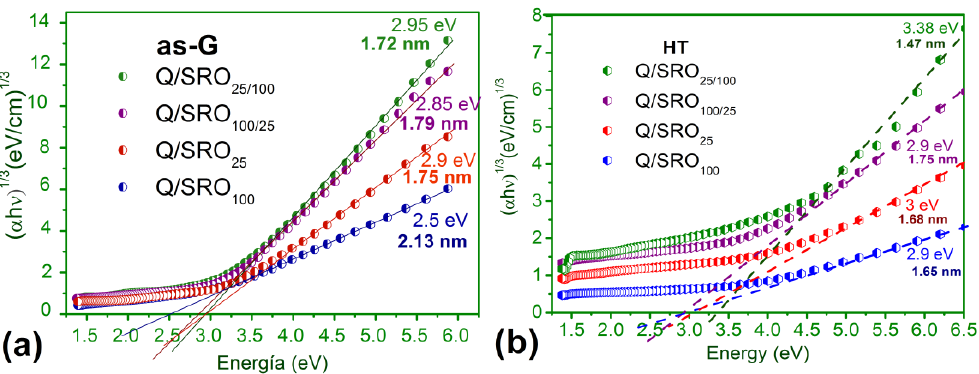
Figure 8. Optical bandgap energy of the SRO films ( a ) as-G and ( b ) with